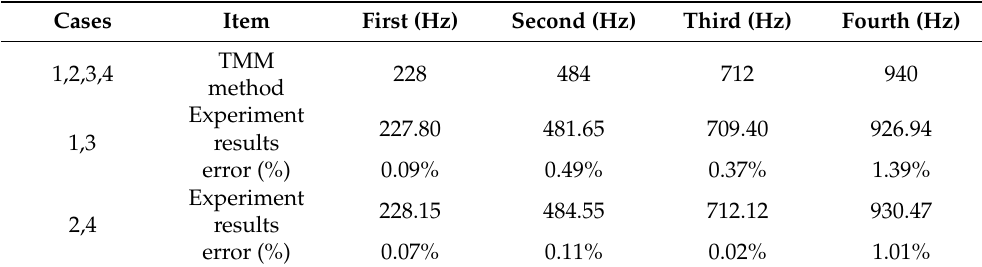
Table 8. Natural frequencies of the fluid pressure of pipe